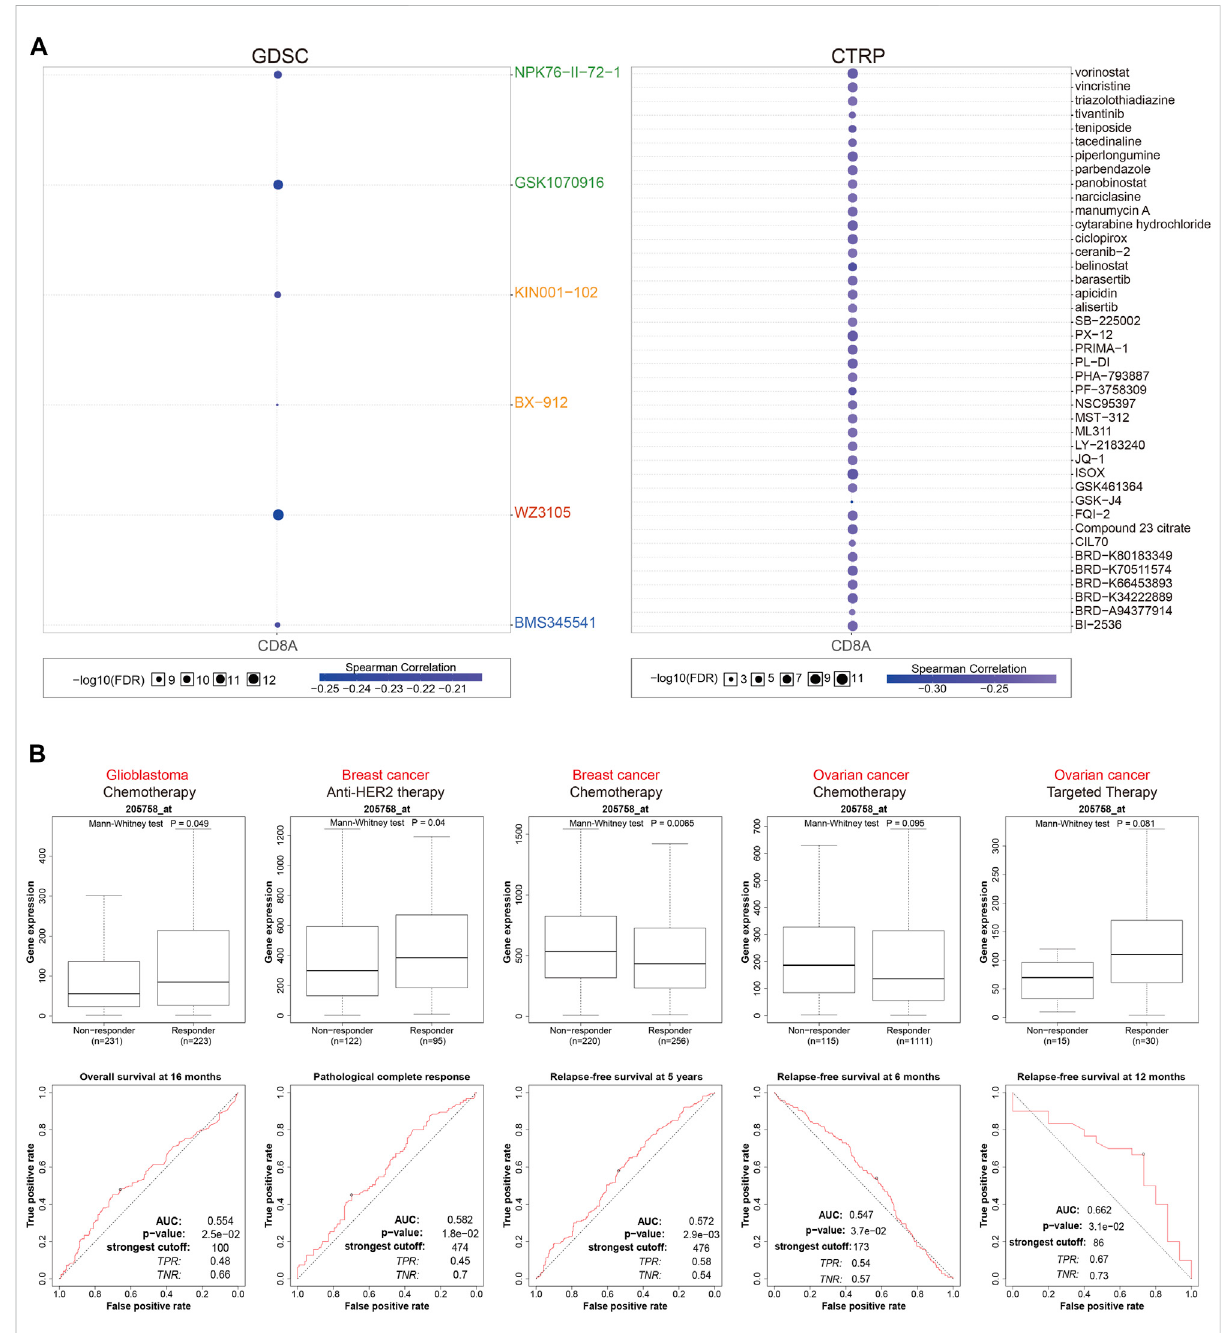
FIGURE 7 CD8A as a therapeutic biomarker indicating multiple anti-tumor agents ’ responsiveness on various cancer cell lines, and cancer cohorts (A)